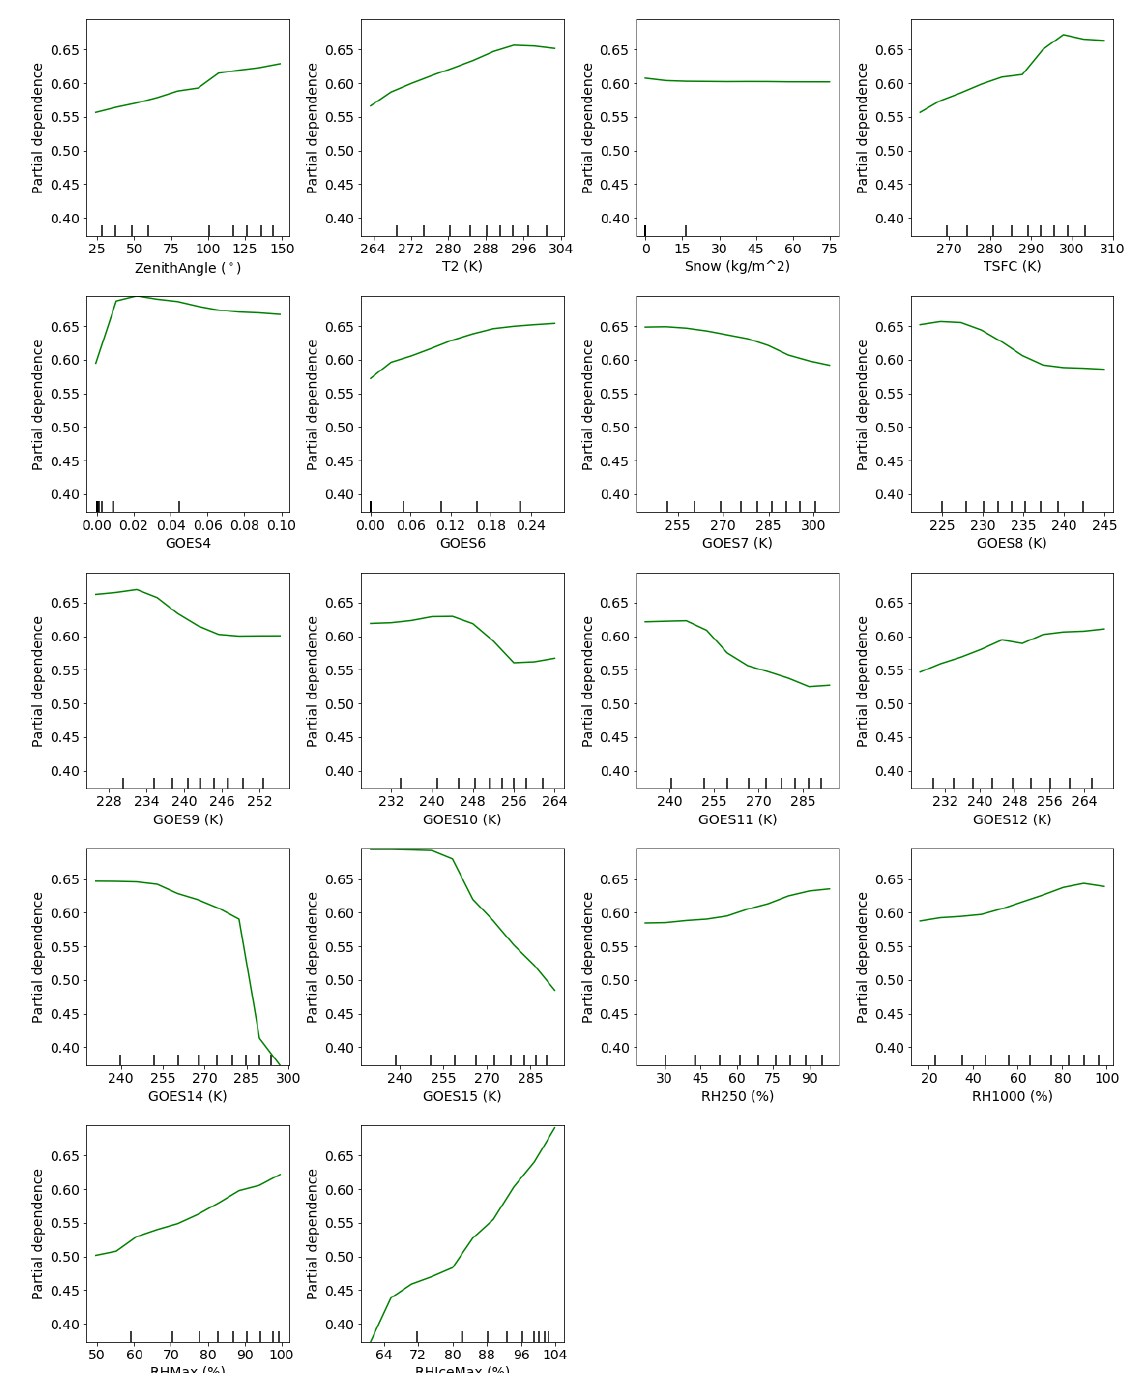
Figure 11. Predictor importance plots showing the relative change in prediction based on each of the variables used in the final model.